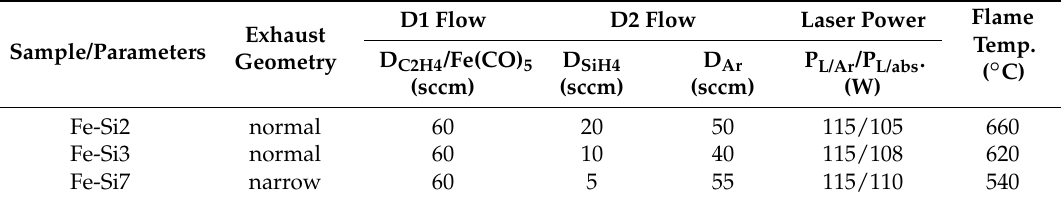
Table 1. Experimental parameters for the standard/rapid quenching laser-assisted synthesis of Fe-Si-based hybrid nanoparticle